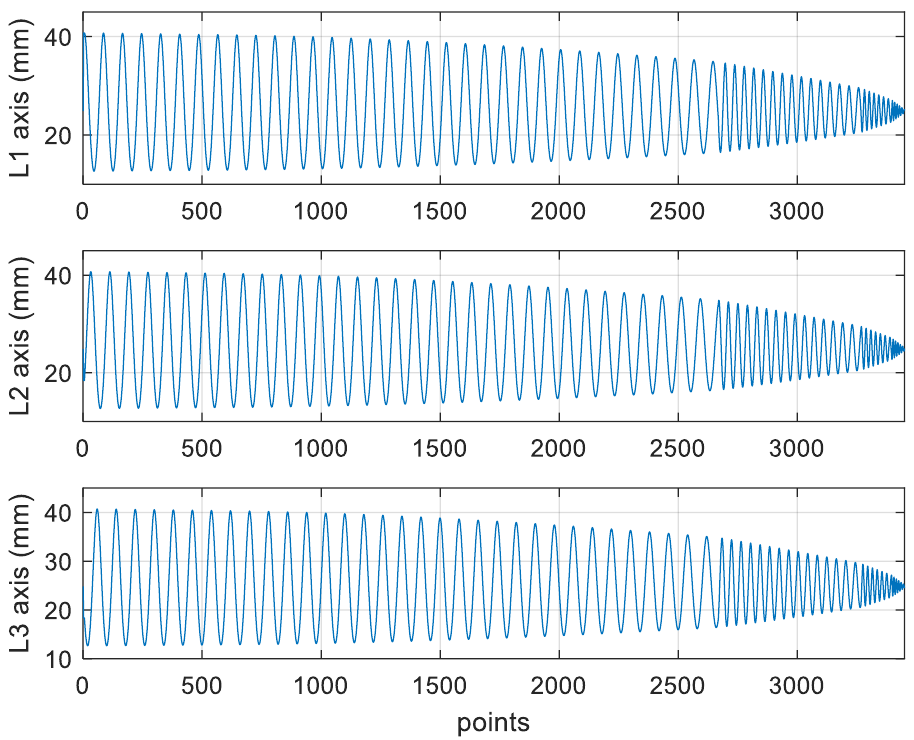
Figure 23. The lengths of the parallel three-axes after converting the finish machining program.